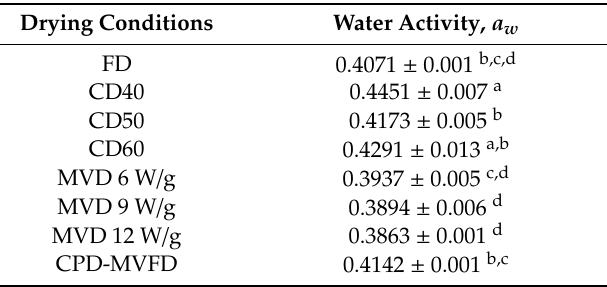
Table 5. Water activity of dried M. koenigii leaves at di ff erent drying conditions.